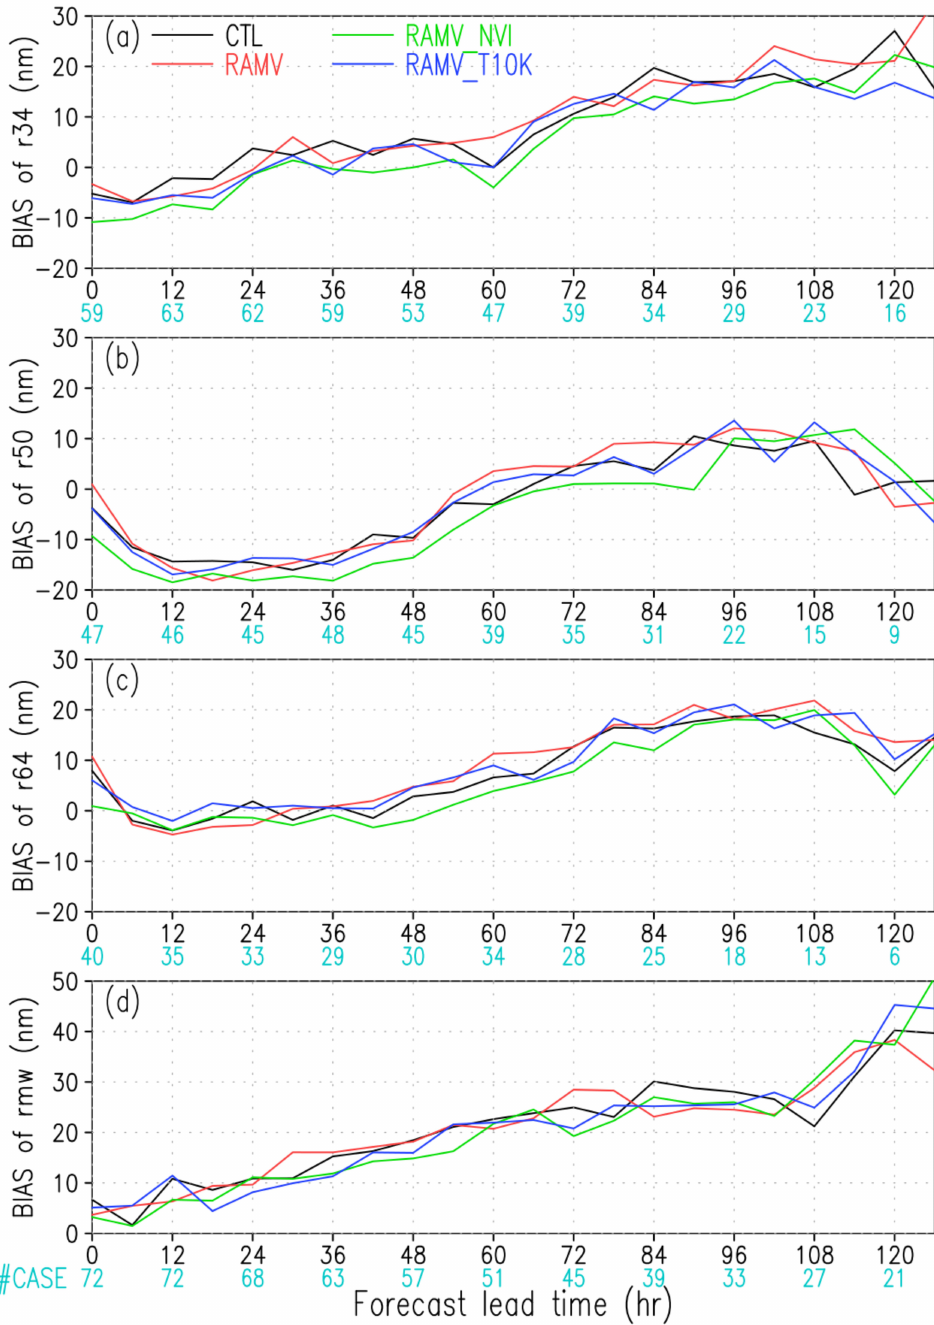
Figure 5. As in Figure 4, but for bias of ( a ) R34, ( b ) R50, ( c ) R64, and ( d ) RMW. Surprisingly, VI has positive impacts on R34 and R50 forecast up to 18 h at most, despite that the significant di ff erence in axisymmetric structures can be analyzed at the initial condition, as shown in Section 3.5. The impacts of VI are neutral for R64 and RMW. The negative biases of R50 and R64 in RAMV_NVI are the largest up to FT = 42 and 30 h, respectively, in all the experiments. The negative bias of R34 was larger at early forecast lead times in RAMV_NVI than in RAMV. These suggest that VI has the e ff ect of expanding the TC size, leading to compensation of the negative size biases. Note that the three typhoon cases selected in this study are very intense, and their inner core structures tend to be axisymmetric based on R64 of best track. In that case, VI could help to improve the representation of the inner core vortex structure. Despite that, the improvement seems to be limited in this